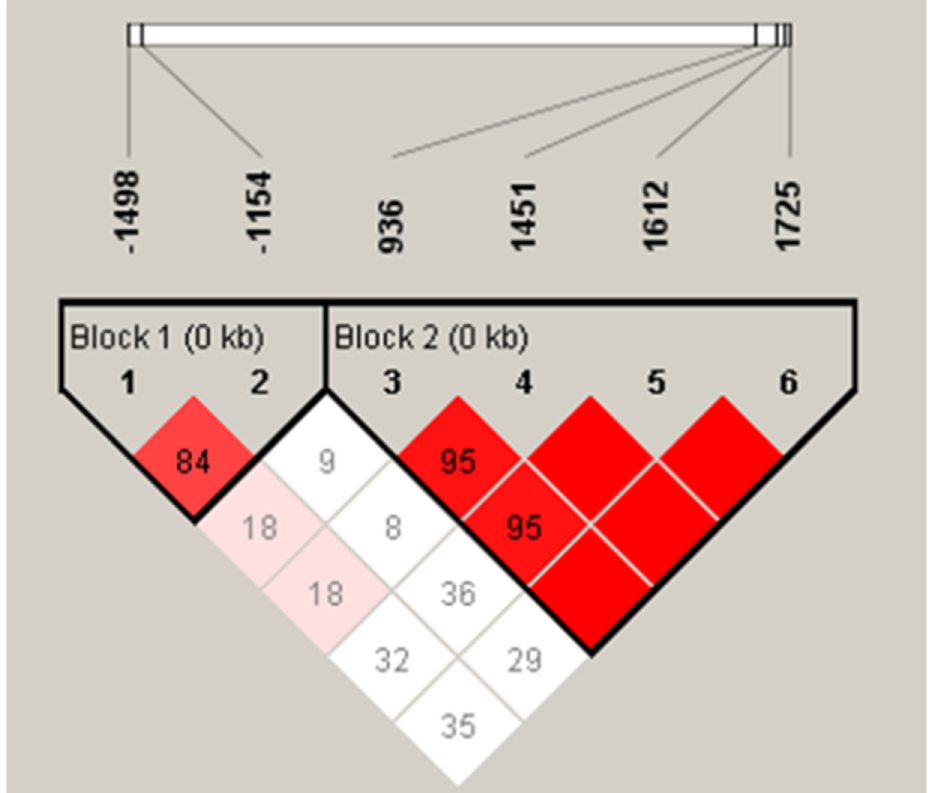
Figure 1. Linkage disequilibrium between VEGF loci. There was strong LDs between loci − 1498T>C and − 1154 (D’ = 0.848), +936C>T and +1451C>T (D’ = 0.957), +936C>T and +1612G>A (D’ = 0.956), +936C>T and +1725G>A (D’ = 1.000), +1451C>T and +1612G>A (D’ = 1.000), +1451C>T and +1725G>A (D’ = 1.000), and +1612G>A and +1725G>A (D’ = 1.000).